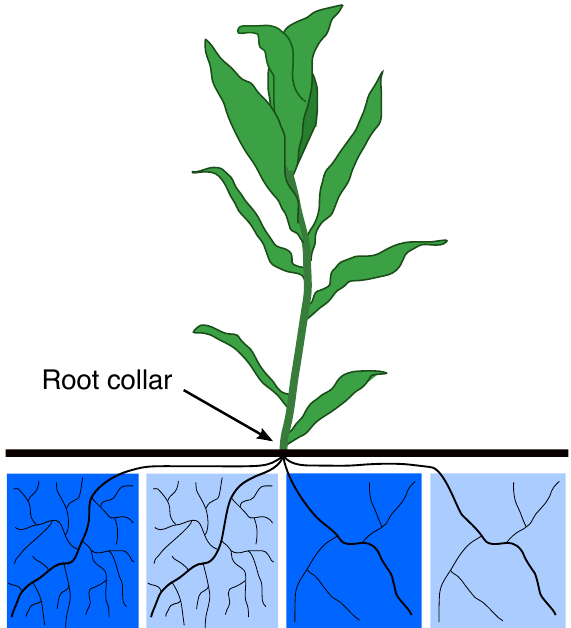
Figure 2. Schematic of the numerical split-root experiment. One plant has access to four soil compartments, two densely rooted (left) and two sparely rooted (right). Color shading of the containers in- dicates high (dark color) and low (bright color) initial soil water content. The average initial soil water content is the same in all simulations. In the same way, the average water content over the two left (densely rooted) and two right (sparsely rooted) containers is the same in all